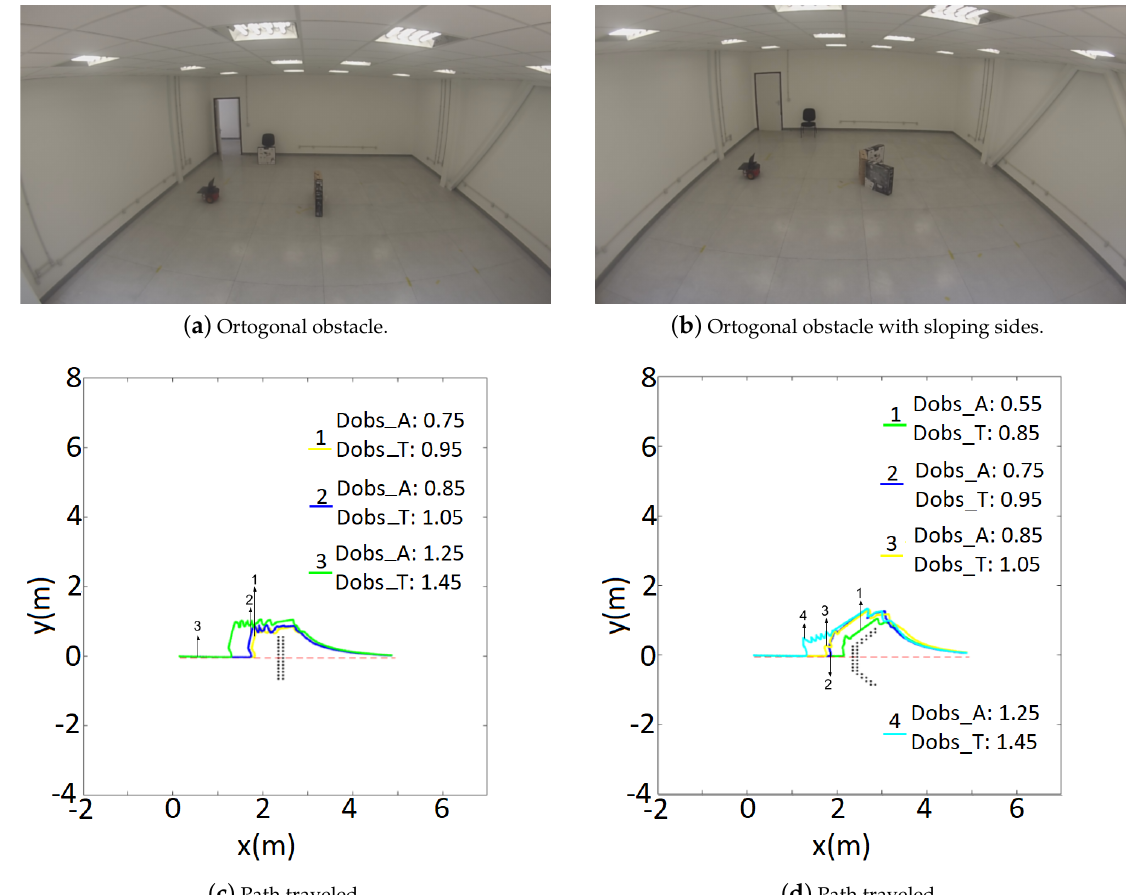
Figure 8. Comparison of tangential escape parameters for a straight line